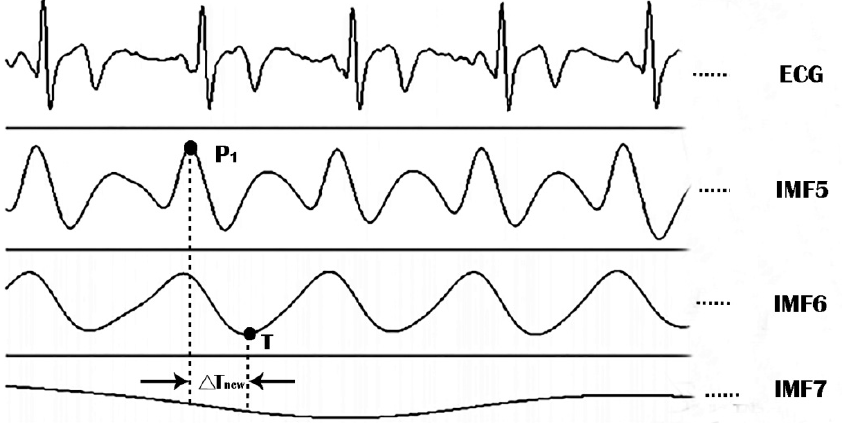
Figure 2. We chose IMF5 and IMF6 from Equation (3) to calculate SI indexes after decomposition of the radial pulse and DVP using EEMD. We automatically computed the time difference ( Δ T new ) between the first IMF5 peak (P 1 ) and IMF6 trough (T) within the same period. We attributed IMF7 to respiratory signals, with a frequency of around 0.2 Hz. Since this signal did not affect the accuracy of the IMF5 signals, we deemed its measurement unnecessary.